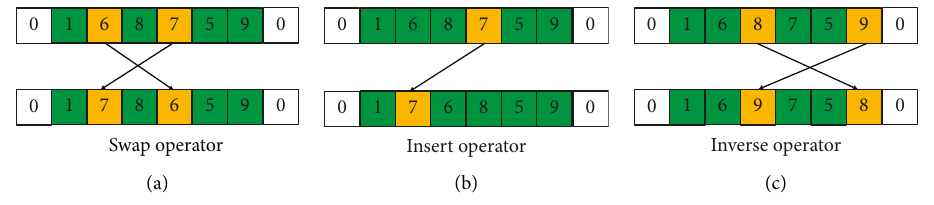
Figure 4: Interroute search. (a) Swap operator. (b) Insert operator. (c) Inverse operator.